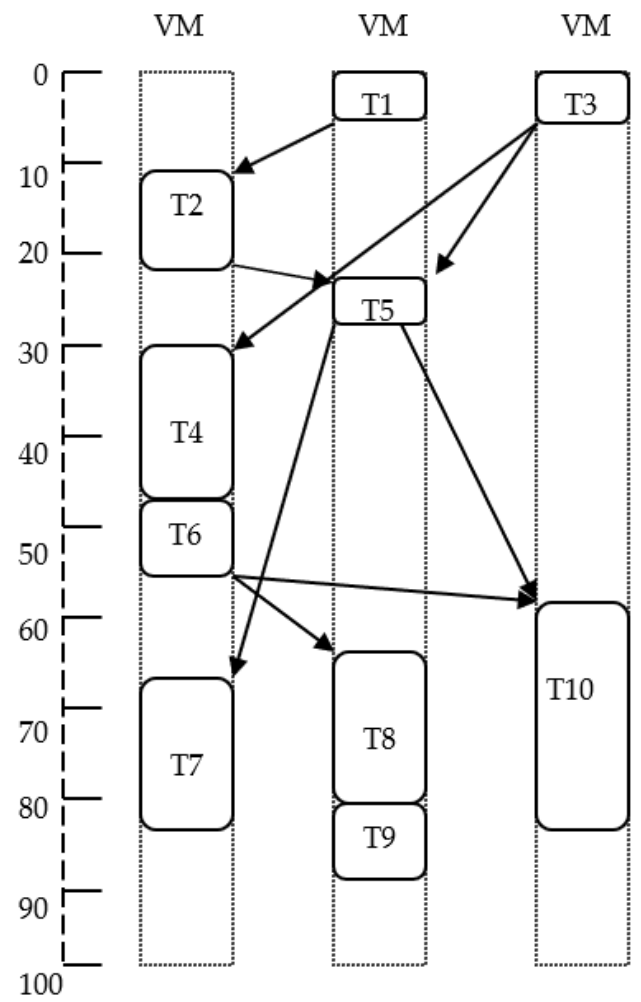
Figure 7. Scheduling of DAG with modified HEFT algorithm (use of minimum schedule length idle slot in processor selection). The schedule length is 89.